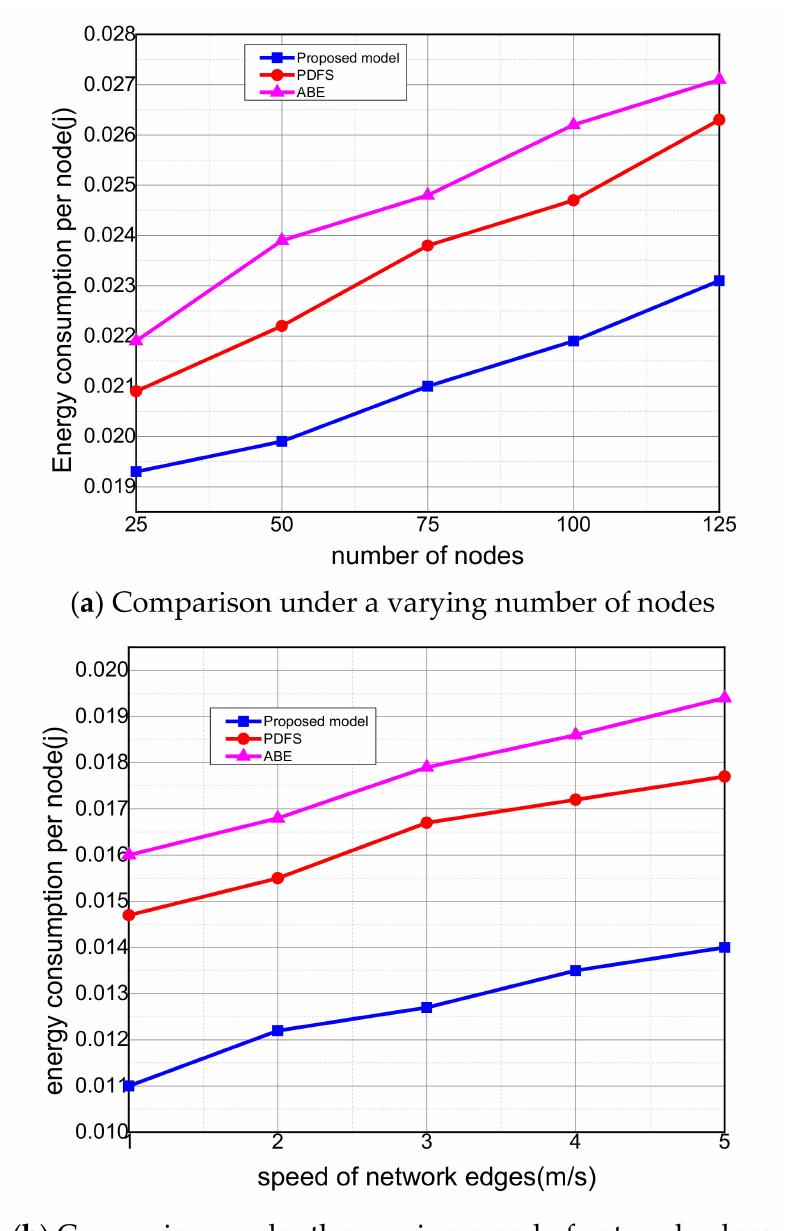
Figure 6. Evaluation of energy consumption per node among proposed model, PDFS,